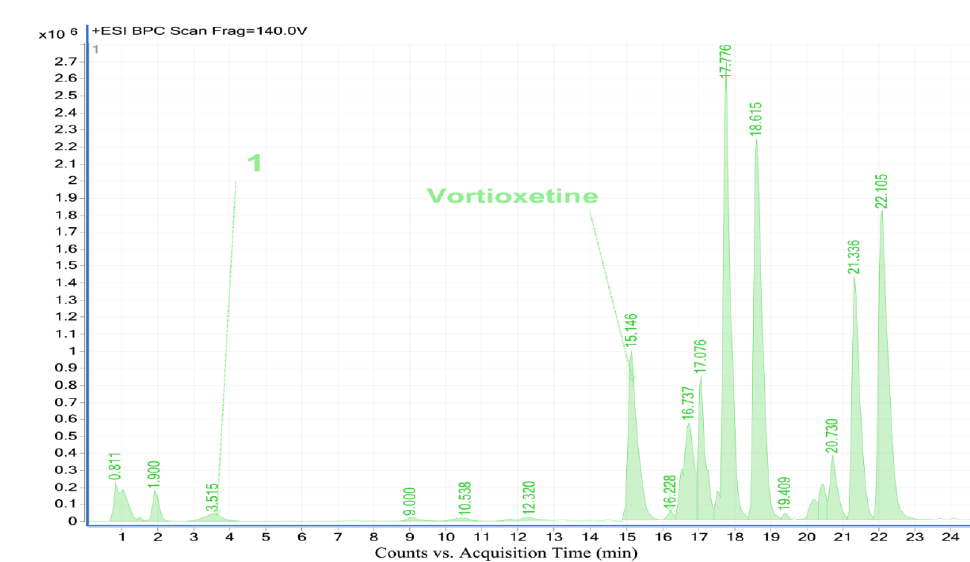
Figure 7. LC-MS chromatogram obtained for saliva sample from patient treated with vortioxetine. The sample was taken ( A ). 1 h and ( B ). 24 h after drug administration.